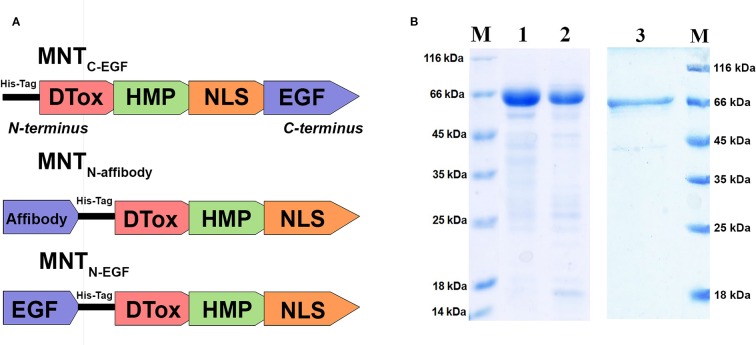
Characteristics of the MNT. (A) A schematic diagram depicting structure of the new MNTN-affibody and MNTN-EGF and previously described MNTC-EGF. (B) SDS-PAGE gels of MNTN-affibody (lane 1), MNTN-EGF (lane 2), MNTC-EGF (lane 3) and unstained protein markers (lane M).